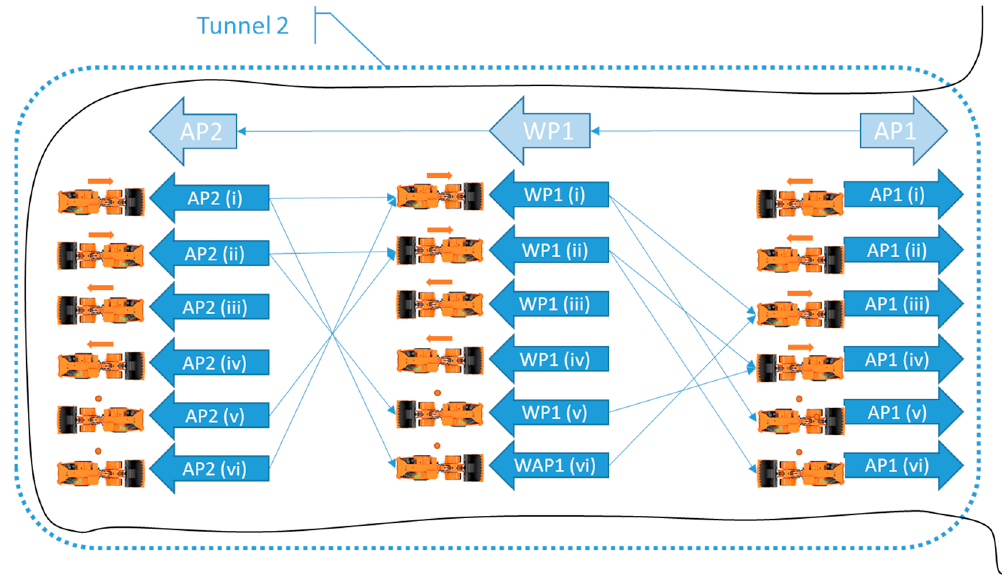
Figure 7. TMM construction example. Connections heading in the opposite direction of the Tunnel are shown.